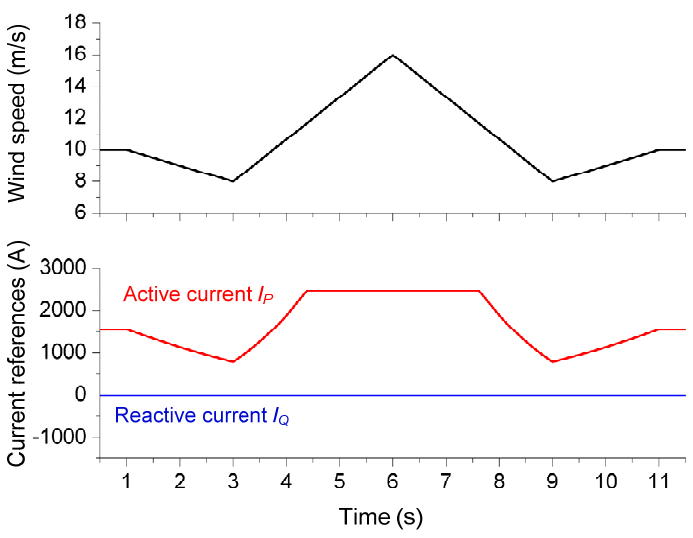
Figure 17. Wind speed and current references of grid side 3L-NPC inverter in a defined wind